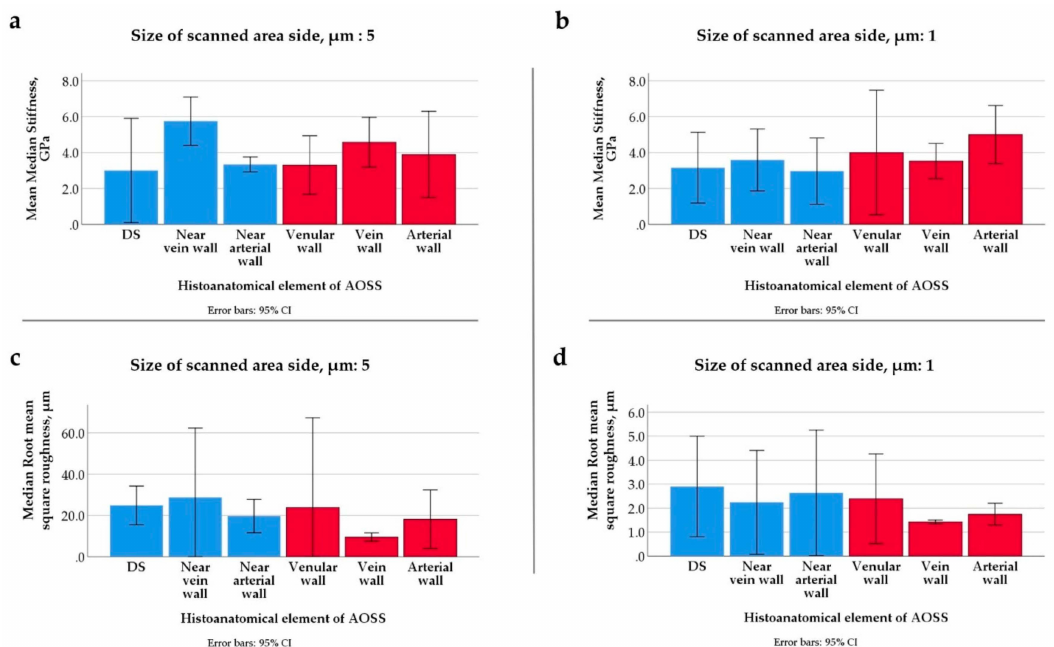
Figure A8. Physical properties of the histoanatomical elements of dehydrated LS-ECM (in CE liver AOSSs) measured in AFM scans with areas 5 × 5 µ m ( a , c ) and 1 × 1 µ m ( b , d ). The elements of the parenchymal compartment are shown by blue bars, and the elements of the stromal compartment are shown by red bars. ( a , b ) Median stiffness and ( c , d ) root mean square roughness. No statistically significant differences of stiffness and roughness were found between the studied histoanatomical elements at both AFM imaging scales (5 × 5 and 1 × 1 µ m) in the given set of samples ( N = 18 for each scanned area size). Abbreviations: DS—Disse’s space; “Near vein wall” and “Near arterial wall,” the properties of the areas of the parenchymal compartment measured in vicinity to veins and arteries, respectively.